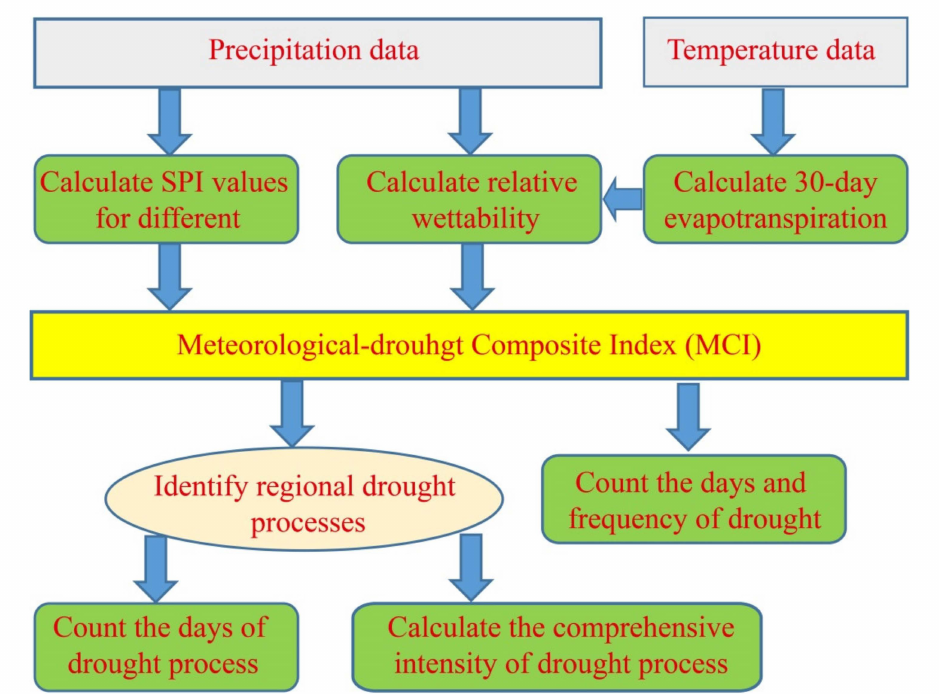
Figure 3. Flow chart for calculating the drought index and the intensity of the drought